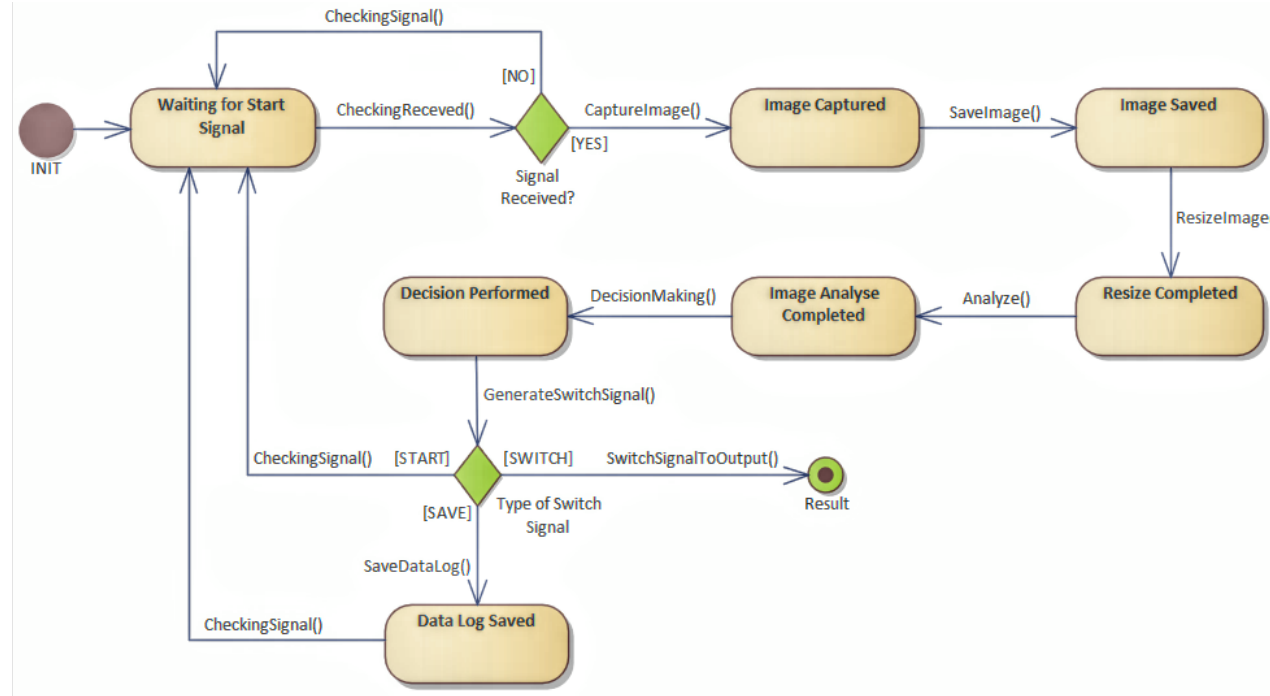
Figure 22. Transformation to high level finite state machine.